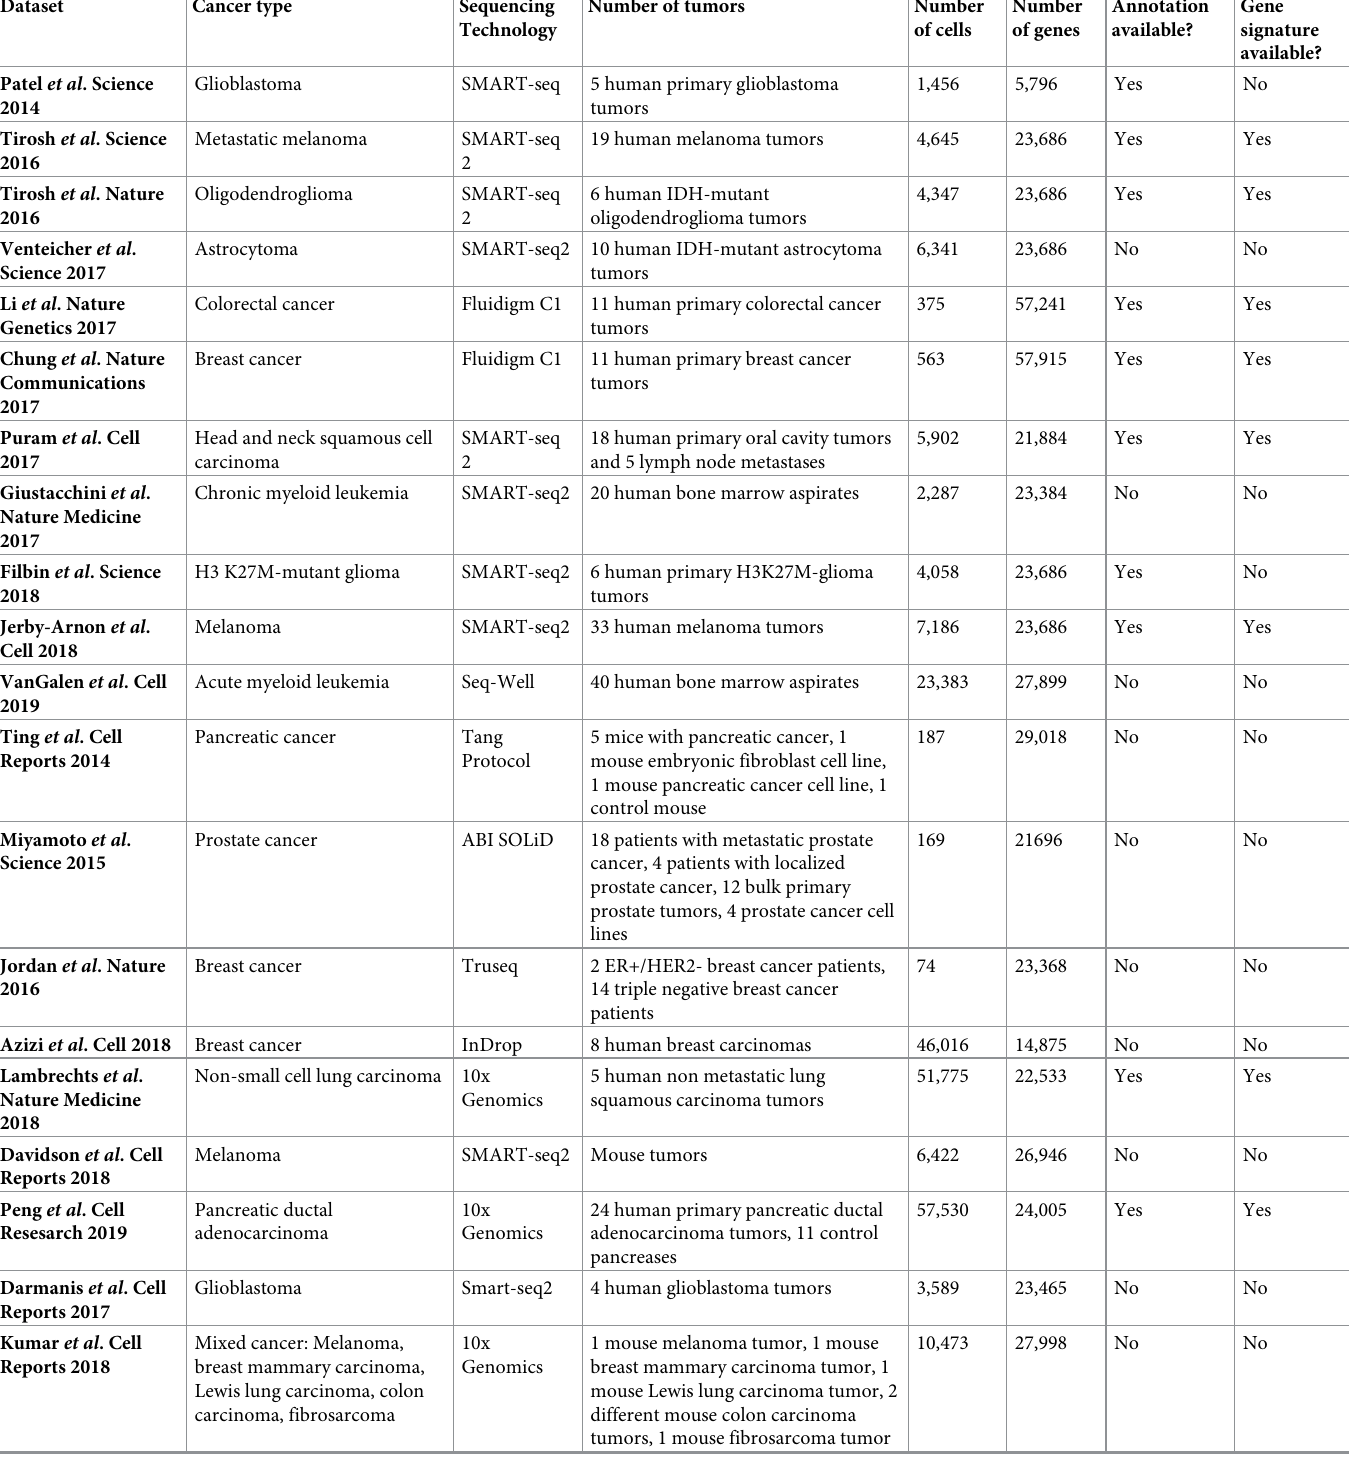
Table 2. List of tumor microenvironment scRNA-seq datasets included in TMExplorer.